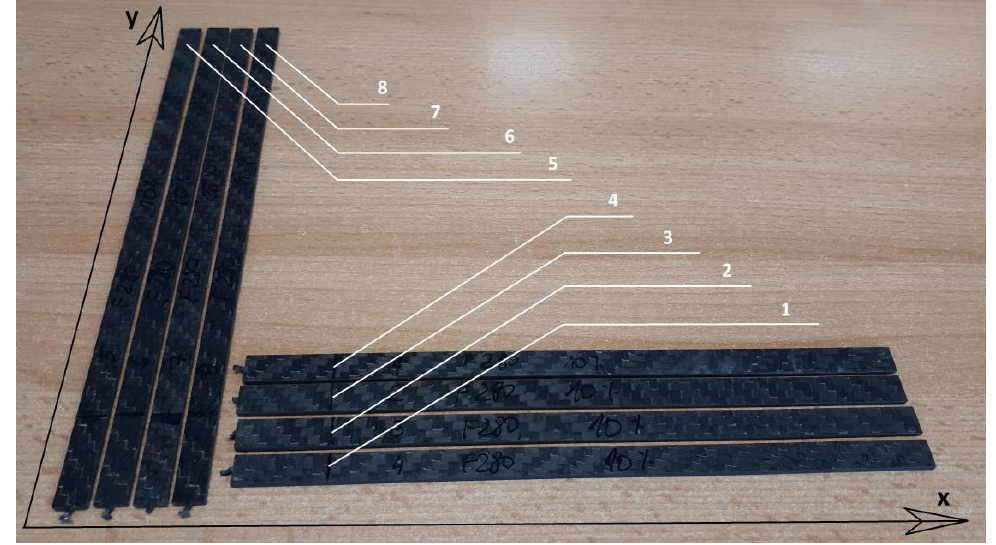
Figure 6. The sample cut along the x and perpendicular y directions.